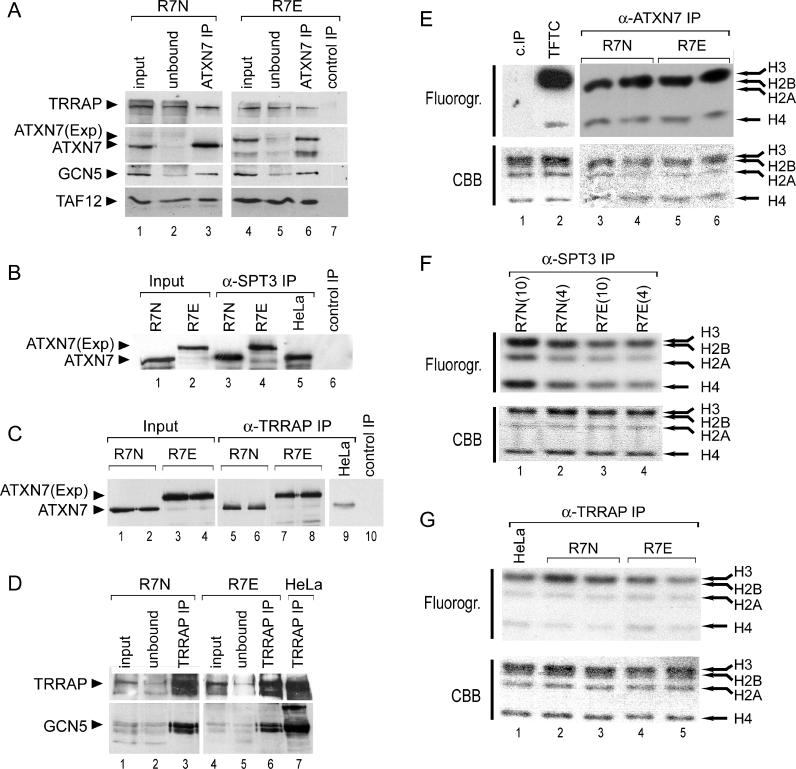
TFTC Subunit Composition and HAT Activity Are Not Altered by PolyQ-Expanded ATXN7 in R7E Retina(A) Western blot analysis of TFTC-type complexes immunopurified from 4-wk-old R7N or R7E retinal homogenates using an anti-ATXN7 antibody. ATXN7 IPs revealed comparable levels of Trrap, Gcn5, and Taf12 in complexes purified from R7N or R7E retina.(B and C) Whole retinal extracts from 4-wk-old R7N and R7E animals were immunoprecipitated with an anti-SPT3 (B) and anti-TRRAP antibody (C). Using the same antibodies, complexes were also immunoprecipitated from HeLa cell nuclear extract as positive controls. The retinal extracts (Input) and the immunopurified complexes were analyzed by immunoblotting with an anti-ATXN7 antibody. Complexes contained similar amounts of normal or mutant ATXN7.(D) Western blot analysis using anti-TRRAP and anti-GCN5 antibodies on complexes immunoprecipitated with an anti-TRRAP antibody from 10-wk-old R7N and R7E retinal homogenates. Using the same antibody, complexes were also immunoprecipitated from HeLa cell nuclear extract as positive controls. Comparable levels of Gcn5 and Trrap were detected in purified complexes from R7N and R7E retina.(E–G) HAT activities of immunopurified complexes bound to either the anti-ATXN7 pAb (E), anti-SPT3 mAb (F), or anti-TRRAP mAb beads (G) from R7N and R7E retina were measured by an in vitro HAT assay performed on free core histones. Histones were separated by SDS-PAGE and stained by Coomassie Brilliant Blue (CBB) and acetylated histones were visualized by fluorography (Fluorogr). The position of each histone is indicated. The pattern of histone acetylation was identical to that of a highly purified TFTC fraction used as a positive control. No histone acetylation could be detected when the antibody was omitted. The age of the mice are indicated in weeks in brackets. These results are representative of three independent experiments. Quantification of all HAT assays performed on R7N and R7E retina is provided inFigure S6A.